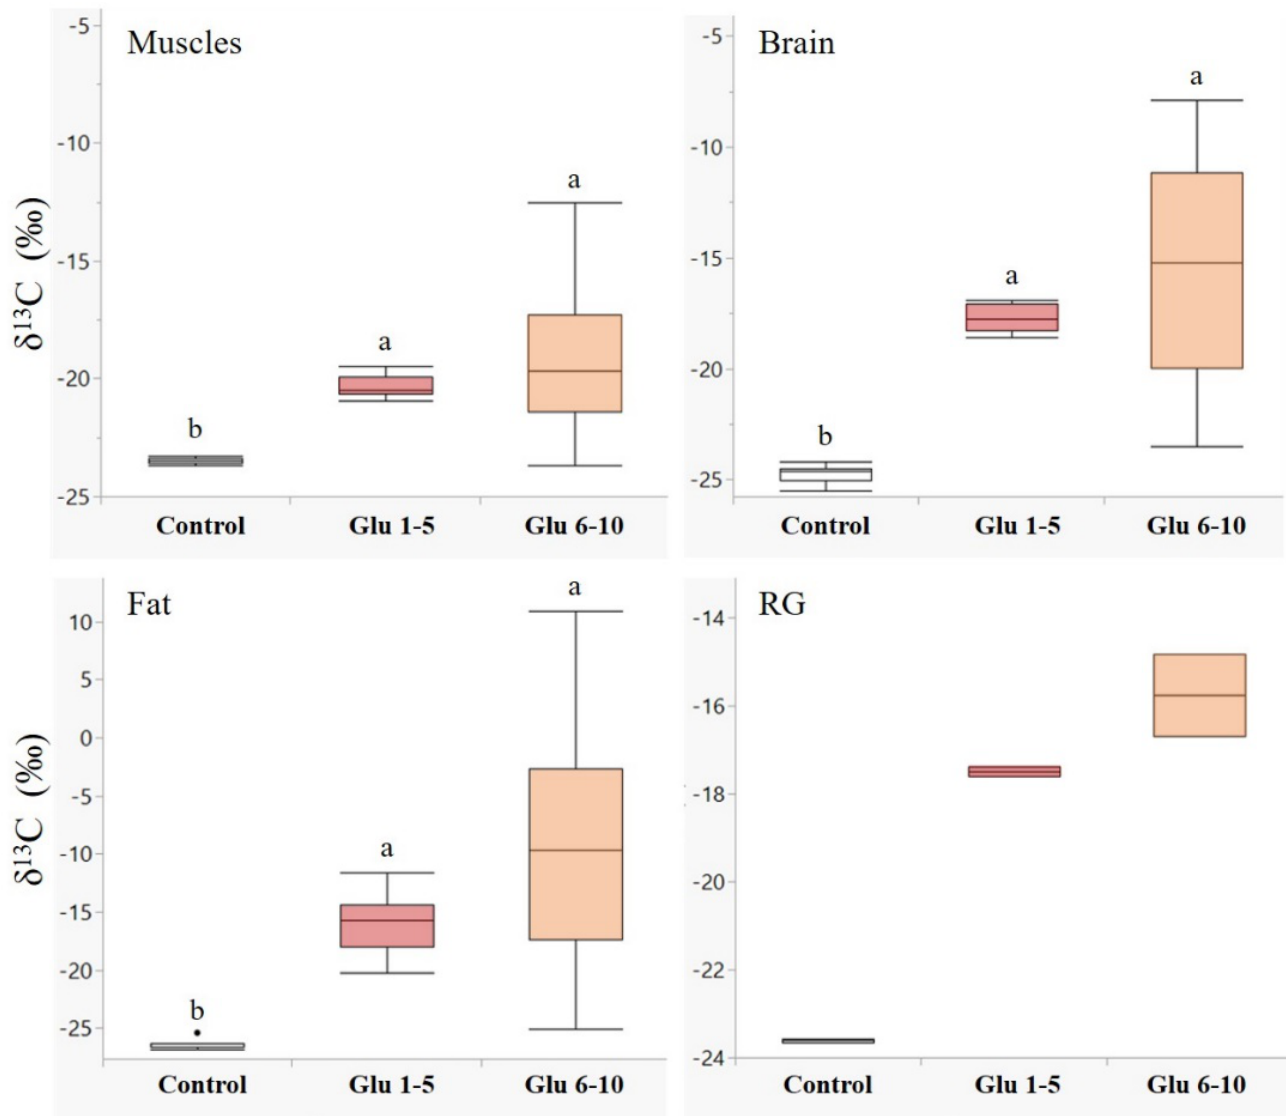
Figure 2. Incorporation of 13 C 1 -glucose in male body tissues. δ 13 C values (‰, median + quartiles) in different tissues of males ( N = 30 for each tissue) following 13 C 1 -glucose treatments. A higher delta indicates higher 13 C levels. Treatments: control—males fed on unlabeled nectar for ten days ( n = 10); Glu 1–5—males fed on 13 C 1 glucose enriched nectar on days 1–5, and unlabeled nectar during days 6–10 ( n = 10); Glu 6–10—males fed on unlabeled nectar during days 1–5 and 13 C 1 glucose enriched nectar during days 6–10 ( n = 10). RG—reproductive glands. Different letters above bars indicate significant differences between diet treatments ( p < 0.05), according to the Wilcoxon test for non-parametric multiple comparisons. For the δ 13 C measurements, see Table